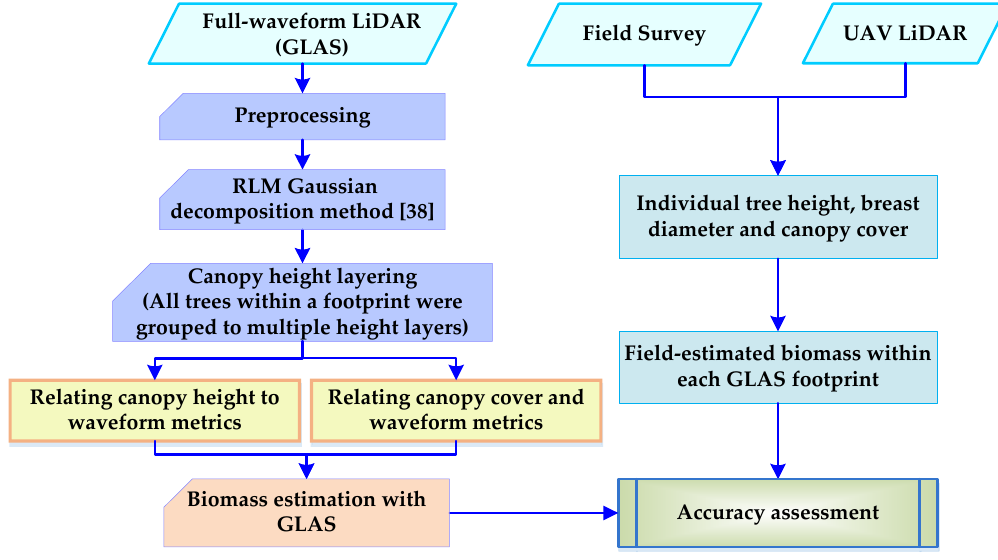
Figure 4. Flowchart in this study.